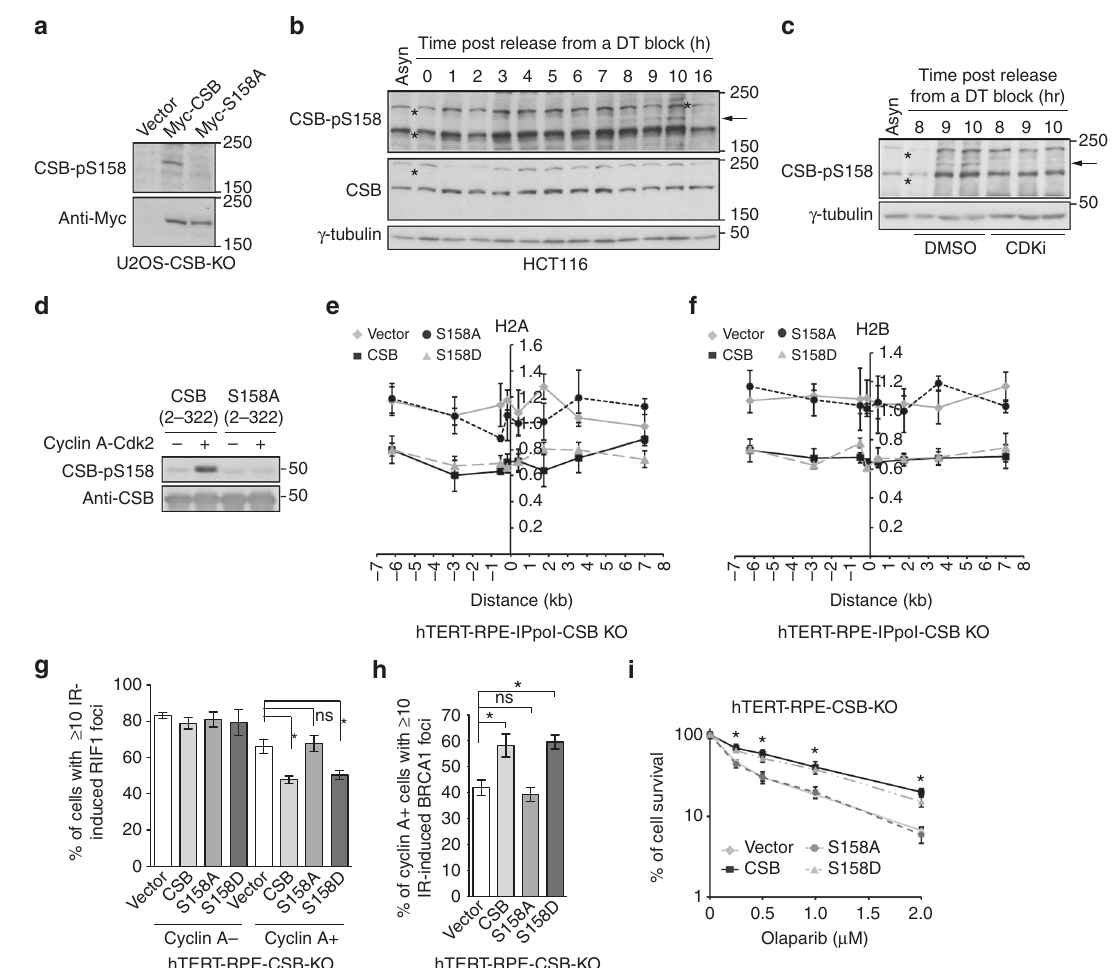
Fig. 8 Cyclin A – CDK2 controls the chromatin remodeling activity of CSB through S158 phosphorylation. a Western analysis of U2OS-CSB-KO cells stably expressing the vector alone, Myc-CSB or Myc-CSB carrying a S158A mutation. Immunoblotting was performed with anti-CSB-pS158 and anti-Myc antibodies. b Western analysis of synchronized HCT116 cells. The arrow indicates the position of CSB-pS158. Asterisks indicate non-speci fi c bands. c Western analysis. Asynchronous and synchronized HCT116 cells post release from a double thymidine block as indicated were treated with DMSO or the CDK inhibitor roscovitine. The arrow indicates the position of CSB-pS158. Asterisks indicate non-speci fi c bands. d In vitro kinase assays with recombinant cyclin A-CDK2 and bacteria-expressed recombinant CSB fragments as indicated. e Relative occupancy of histone H2A in ddI-PpoI-expressing hTERT-RPE CSB KO cells complemented with various alleles as indicated. Both x - and y -axes are as described in Fig. 5a. SEM from three independent experiments are indicated. f Relative occupancy of histone H2B in ddI-PpoI-expressing hTERT-RPE CSB KO cells complemented with various alleles as indicated. Both x - and y -axes are as described in Fig. 5a. SEM from three independent experiments are indicated. g Quanti fi cation of the percentage of cyclin A − and cyclin A+ cells with 10 or more IR-induced RIF1 foci. hTERT-RPE CSB KO cells stably expressing various alleles as indicated were treated with 2 Gy IR and fi xed 1 h post IR. A total of 500 – 550 cells were scored for each independent experiment in a blind manner. SDs from three independent experiments are indicated. * P < 0.05. ns: P > 0.05 (Student t test). h Quanti fi cation of the percentage of cyclin A+ cells with ≥ 10 IR-induced BRCA1 foci. Scoring was done as in 8 g. SDs from three independent experiments are indicated. * P < 0.05. ns: P > 0.05 (Student t test). i Clonogenic survival assays of olaparib-treated hTERT-RPE CSB-KO cells complemented with various alleles as indicated. SDs from three independent experiments are indicated. * P < 0.05 (Student t test) for comparison between CSB and S158A